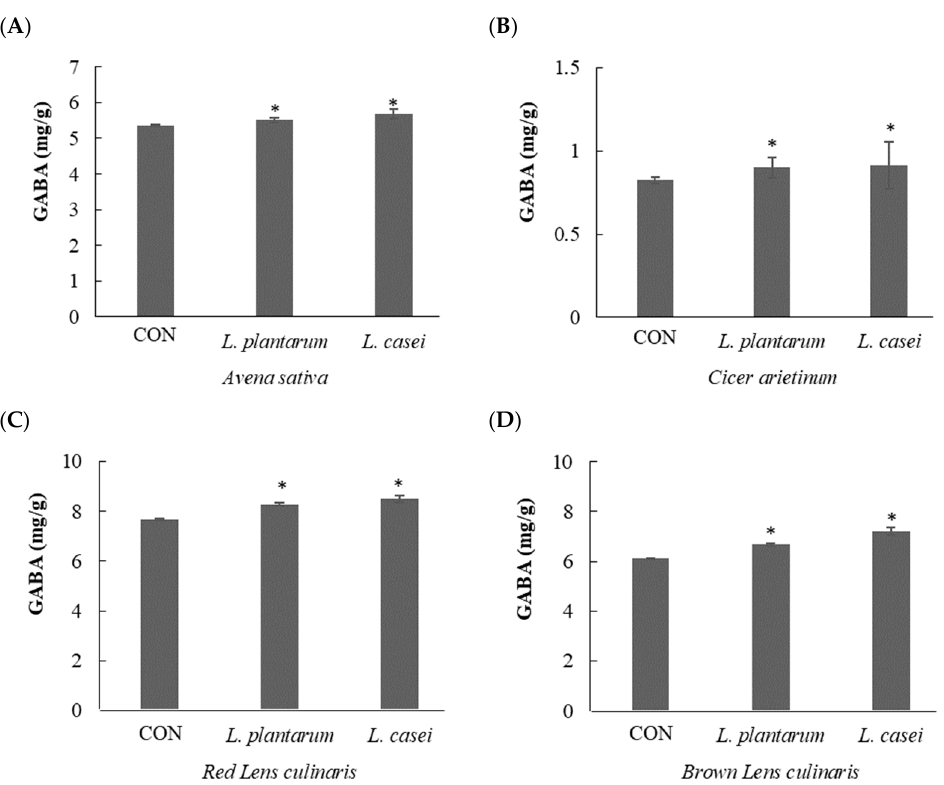
Figure 6. GABA contents of Avena sativa ( A ), Cicer arietinum ( B ), red Lens culinaris ( C ), and brown Lens culinaris ( D ) extracts. CON: Control; Each bar is the mean ± standard deviation of the results from three different analyses ( n = 3). * p < 0.05, significantly different from control (Student’s t -test).